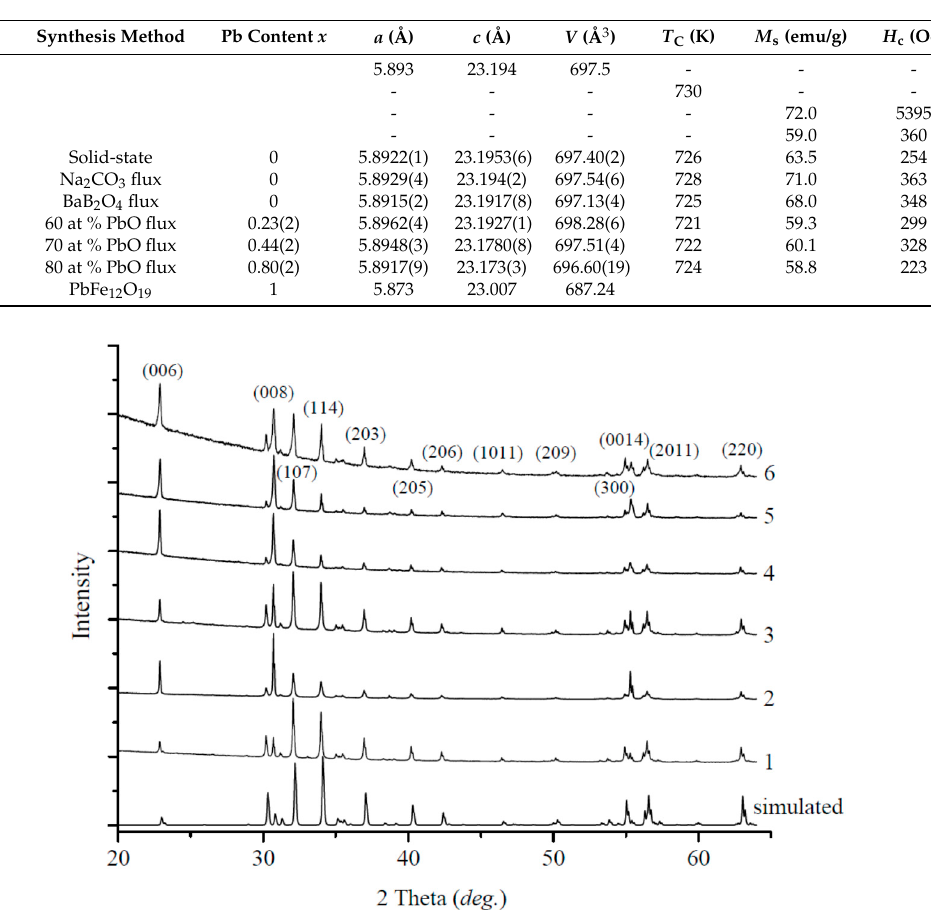
Figure 2. Powder XRD patterns of experimental samples and literature data (bottom) [32]. Differences arise due to minor variations in intensities according to the substitution of Ba by Pb, and mostly different degrees in preferred orientation of grains.